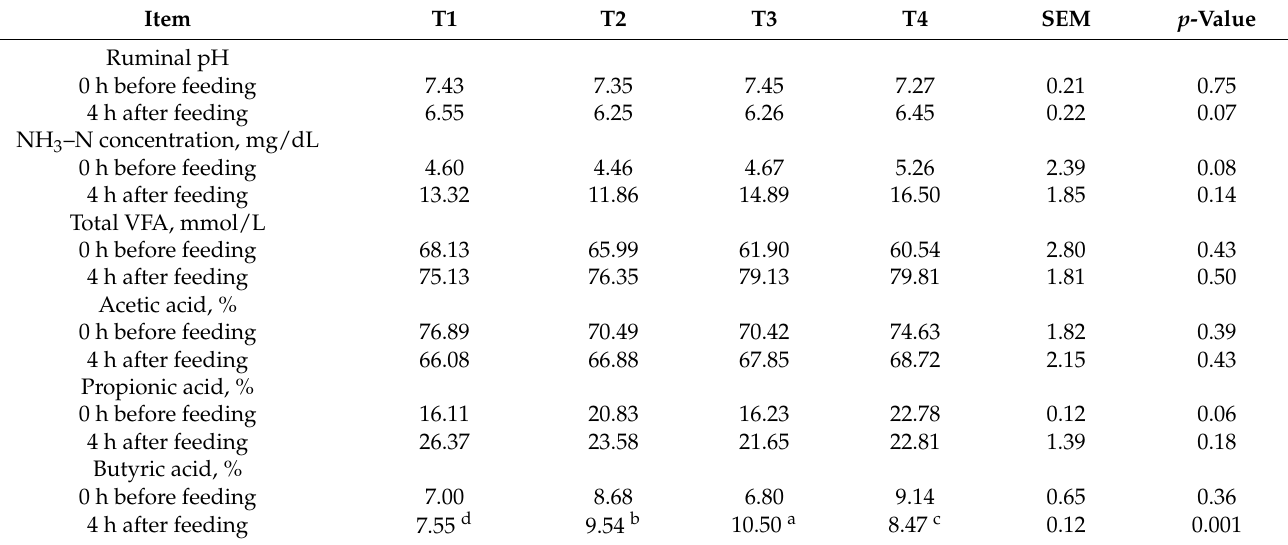
Table 4. Characteristics of ruminal fermentation in Thai native sheep fed fermented sugarcane bagasse with or without additives as roughage